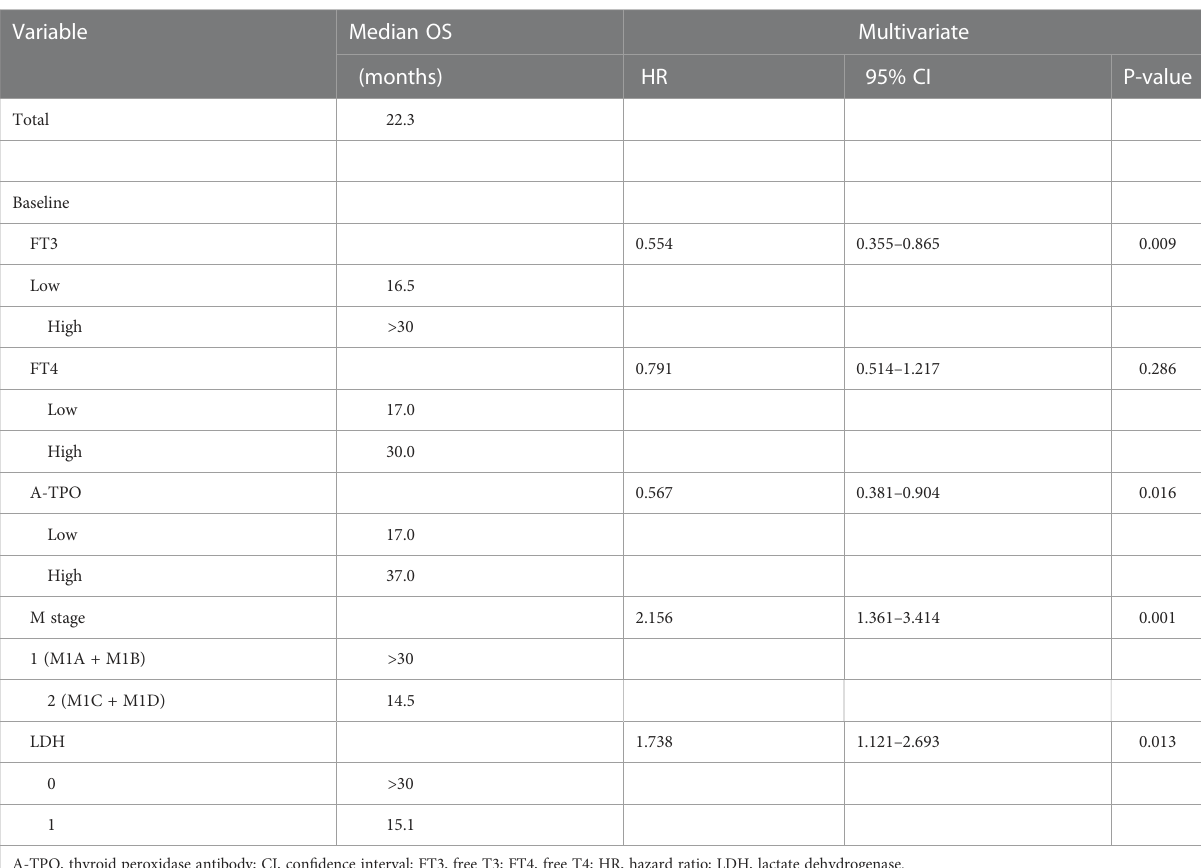
TABLE 4 Multivariate Cox regression analysis of in fl uencing factors of overall survival (OS).